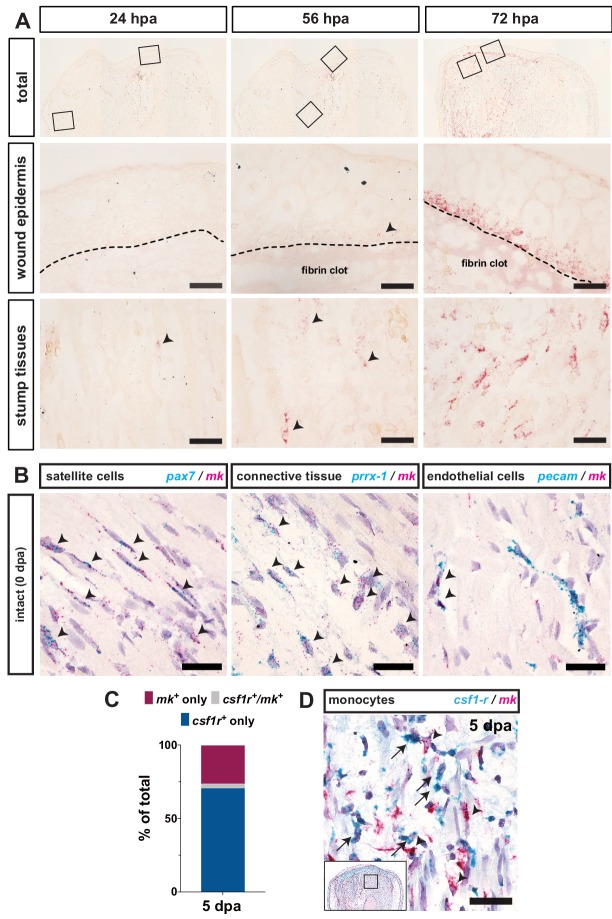
Mk is expressed in satellite cells, connective tissue, and endothelial cells in intact tissues.(A) RNAscope in situ hybridization of mk at 24, 56, and 72 hpa. Dotted line denotes wound epidermis boundary. Black arrowheads point to examples of mk+ cells. (B) Double RNAscope in situ hybridization of mk in red and pax7 (left) (N = 1073 cells counted), prrx-1 (middle) (N = 1723 cells counted), and pecam (right) (N = 1693 cells counted) in blue in non-regenerating intact limbs. Black arrowheads mark double positive cells. (B) Quantification of mk+ only, csf1r+ only, and co-positive cells. (C) Double RNAscope in situ hybridization of mk and csf1r at 5 dpa reveals discrete expression patterns (N = 582 cells counted). Black arrowheads denote mk+ only cells and black arrows denote csf1r+ only cells. Scale bars are 50 µm. hpa, hours post-amputation, dpa, days post-amputation.